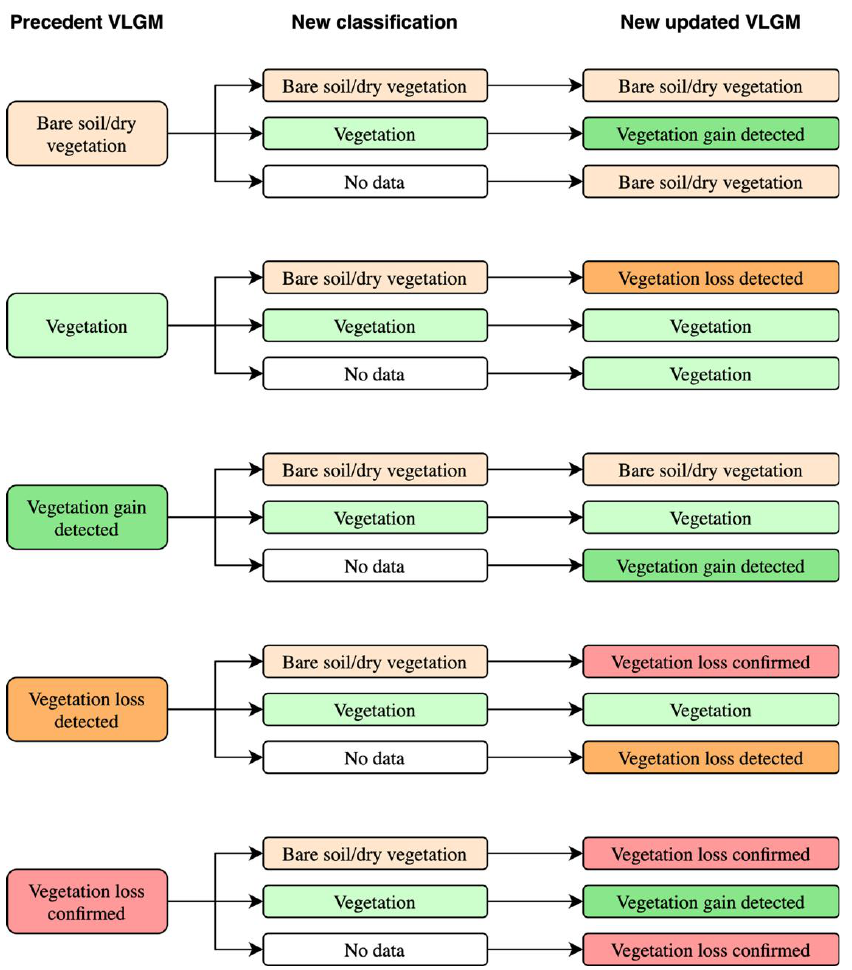
Figure 7. Interpretation strategy for Script 4.